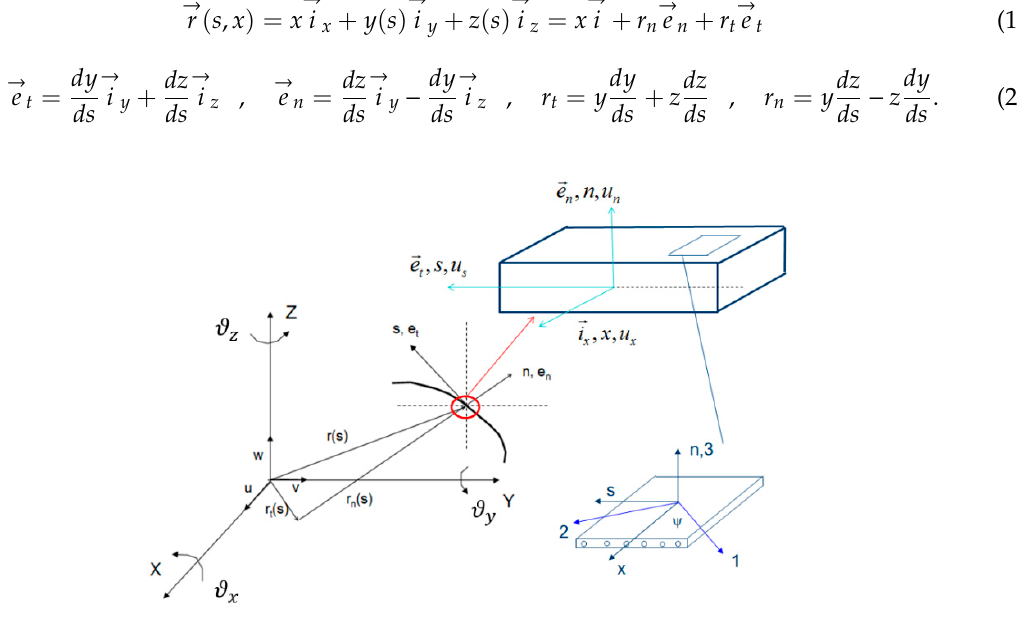
Figure 2. Reference system and sign convention.